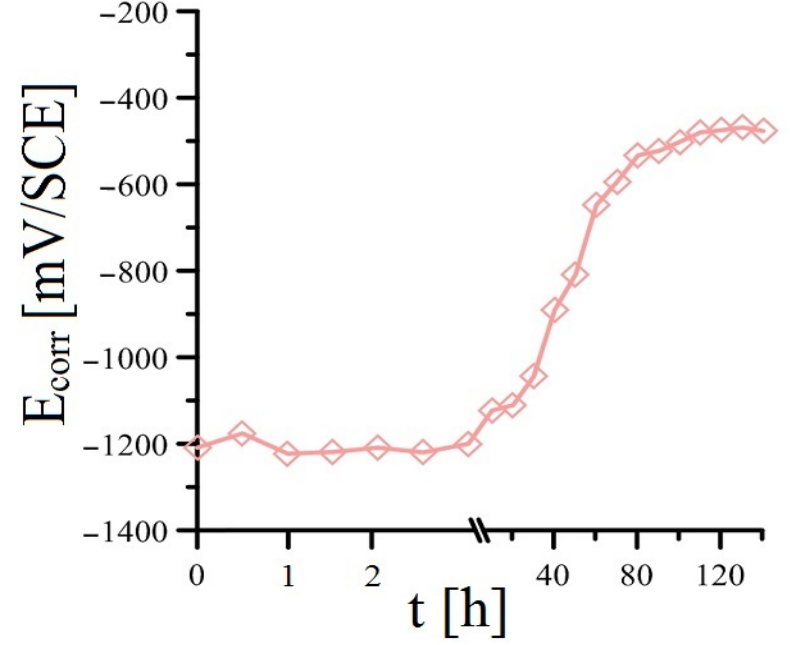
Figure 6. Evolution of open-circuit potential (E corr ) in samples of HDG steel in concrete with addition of MnO 4 − (Mn (1) )—(mean values).